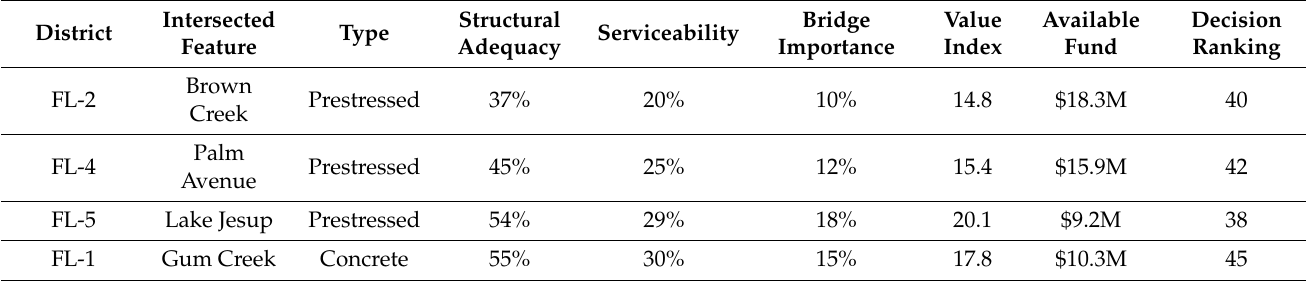
Table 1. A small sample from the generated data showing bridges from different districts.